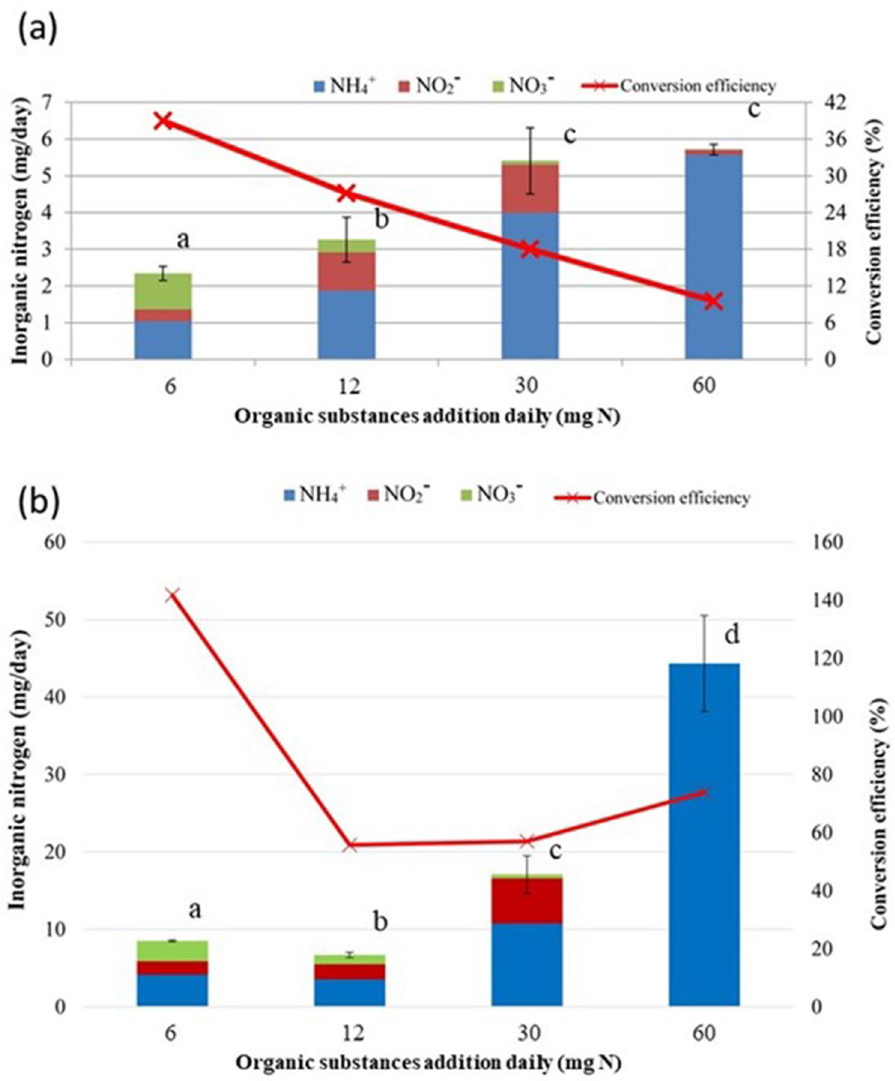
Figure 3. Effect of excessive addition of an organic substance and the resulting inorganic N composition. ( a ) We added 6 mg N of fish fertilizer daily for 2 weeks until nitrate was detected in the leachate and then added 6 to 60 mg N of fish fertilizer for 2 weeks. ( b ) Immediately after addition of bark compost, we added the indicated amounts of fish fertilizer for 2 weeks. The composition of inorganic N in the leachate was then measured. Values are means ± SD ( n = 3). Bars labelled with the same letter do not differ significantly (Fisher’s protected LSD test, P <